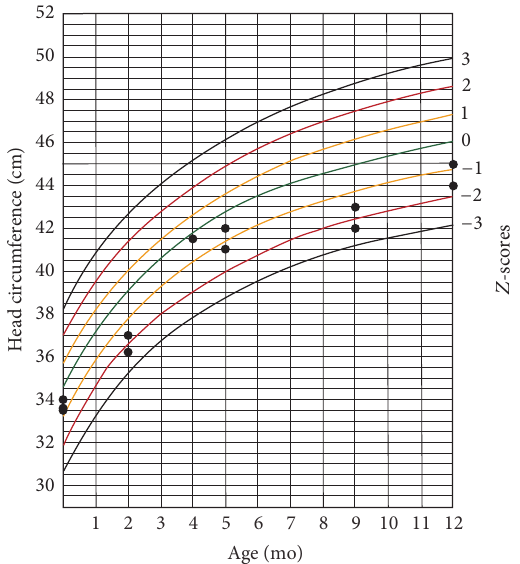
Figure 3: Head circumference-for-age chart for boys during one- year follow-up.